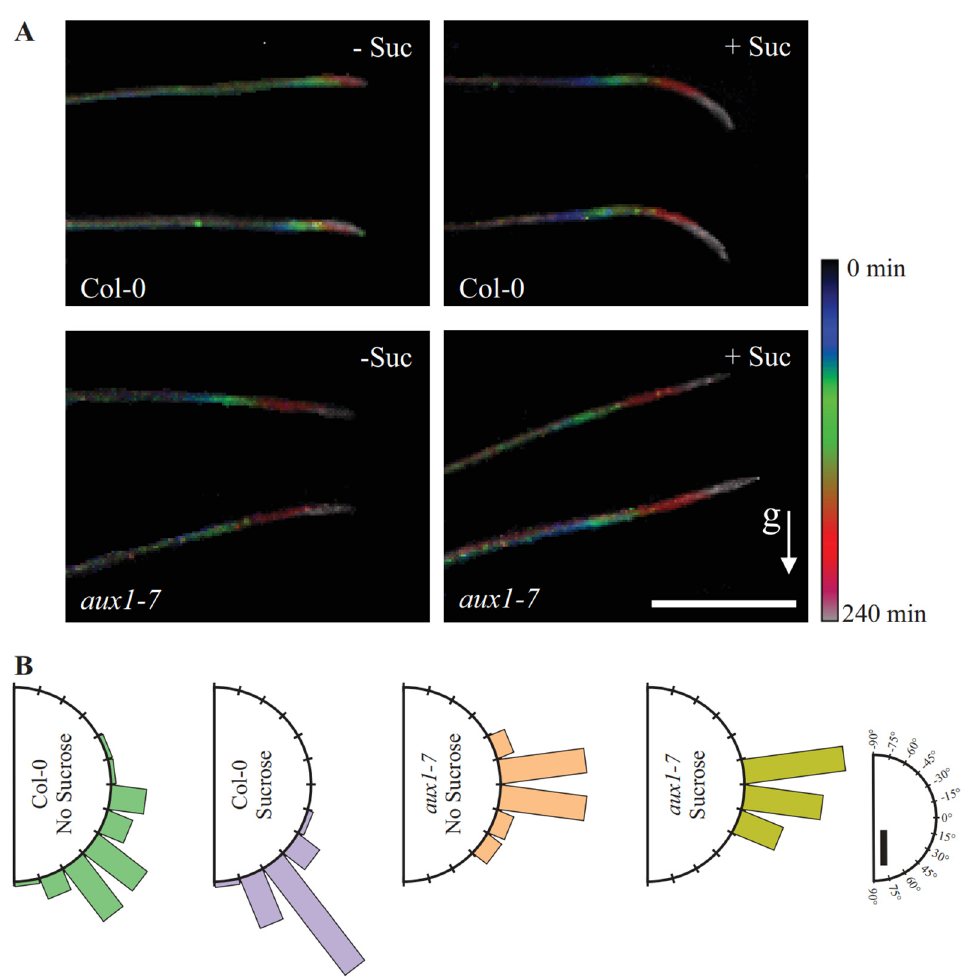
Figure 5. Gravitropic bending analysis. ( A ) Maximum projection of time-lapse imaging of root bend- ing in unsupplemented and sucrose supplemented wild-type and aux1-7 medium. Scalebar = 2 mm. Root imaging was carried out at time 0 (dark blue), 15, 30, 60, 120, 180, and 240 (light pink) minutes after turning the plates 90 degrees. ( B ) Root tip angle 240 min after gravistimulation. Roots were assigned to 15° sectors in a gravitropism diagram, and the percentage of roots belonging to each sector is represented by bars. Scalebar = 20%. (Col-0, n = 42 ₋ 51 roots; aux1-7 , n = 13 ₋ 20 roots). The maximum projection of the time-lapse images that we took every 30 min for four